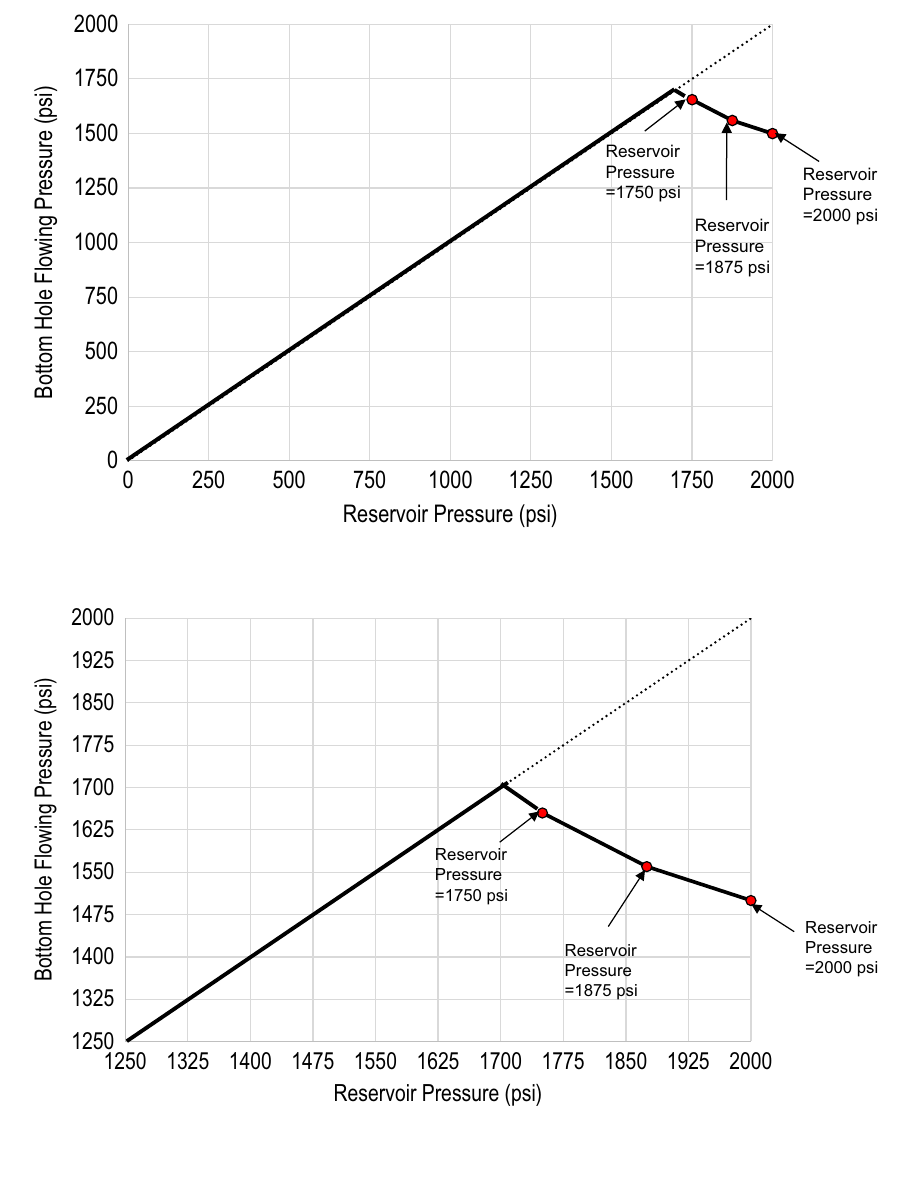
Fig. 28 Safe drawdown line plot from numerical analysis